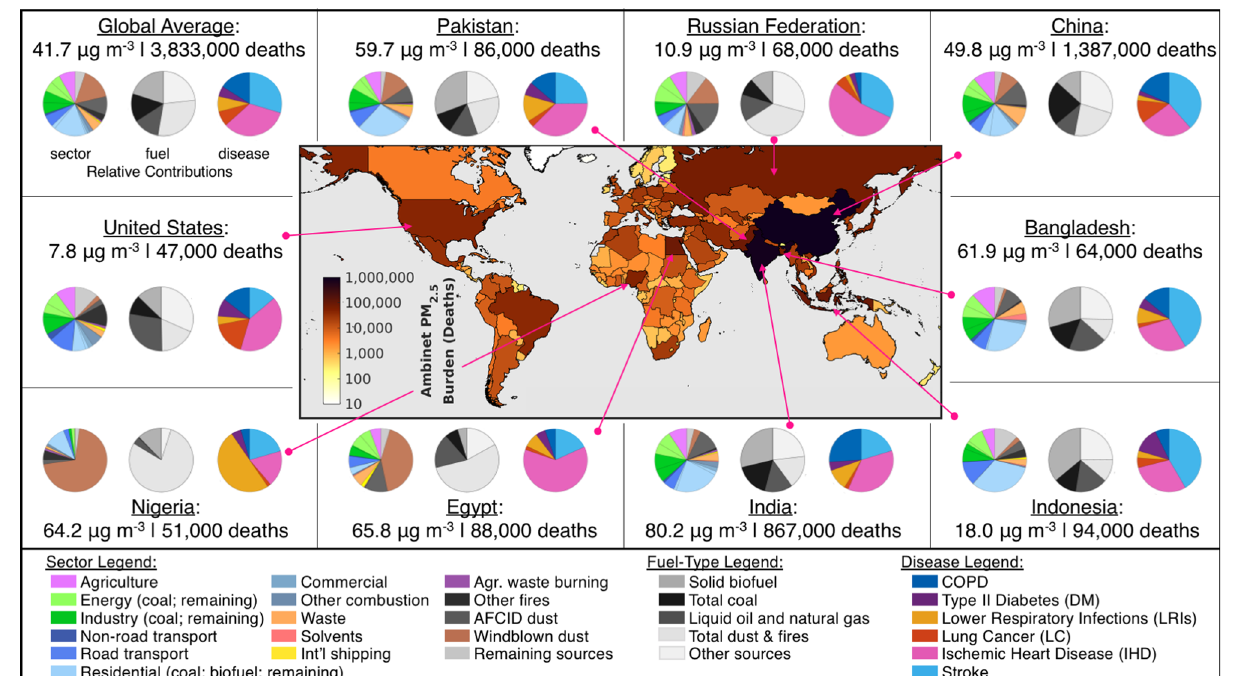
Fig. 2 Absolute ambient PM 2.5 burden and fractional sector, fuel, and disease contributions for the global average and top nine countries. Map: National-level outdoor PM 2.5 disease burden in 2017 (from the 2019 Global Burden of Disease concentration-response relationships). Panels : Annual average population-weighted PM 2.5 exposure levels and attributable mortality (rounded to the nearest 1000). (Left pie charts) fractional sectoral source contributions. ‘ Other fi res ’ include deforestation, boreal forest, peat, savannah, and temperate forest fi res. ‘ Remaining sources ’ include volcanic SO 2 , lightning NO x , biogenic soil NO, aircraft emissions, and oceanic and biogenic sources (Supplementary Table 2). Energy and industry sectors also include separate contributions from coal use ( fi rst wedge, counterclockwise). The residential sector separates the contributions from coal ( fi rst wedge) and solid biofuel (second wedge). (middle pie charts) fuel-type contributions. The ‘ total dust & fi res ’ category is the sum of windblown and AFCID (anthropogenic fugitive, combustion, and industrial) dust, agricultural waste burning, and other fi res. Other sources are primarily from non-combustion or uncategorized combustion sources (agriculture, solvents, biogenic SOA, waste incineration, etc.). (Right pie charts) Relative disease contributions (not including pre-term birth and low birth weight). Supplementary Data 1 and 2 provide all data in this fi gure, including the number of neonatal